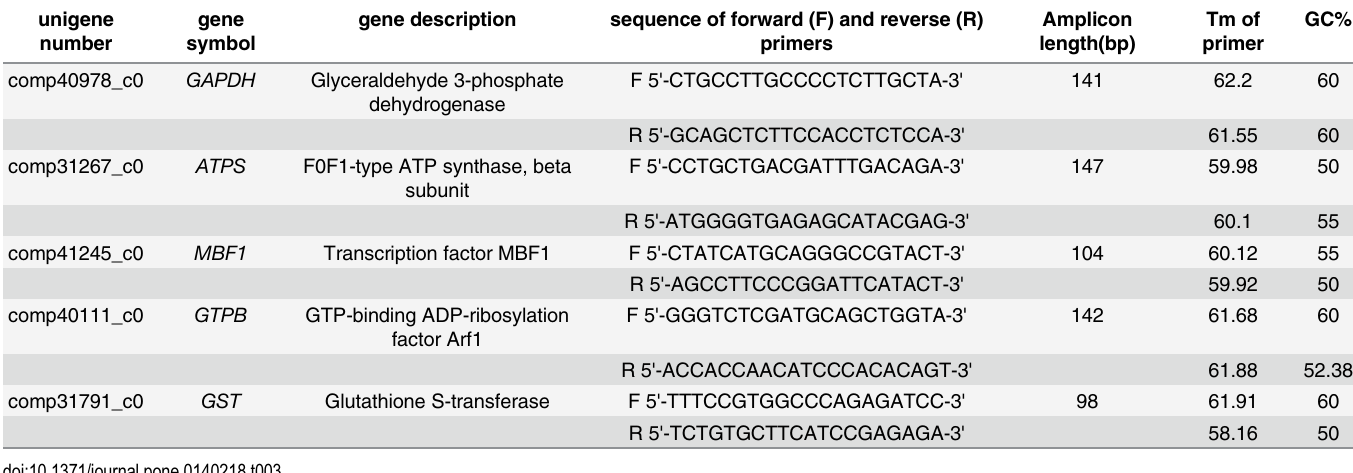
Table 3. The primer description of 5 candidate RGs evaluated in this study. unigene